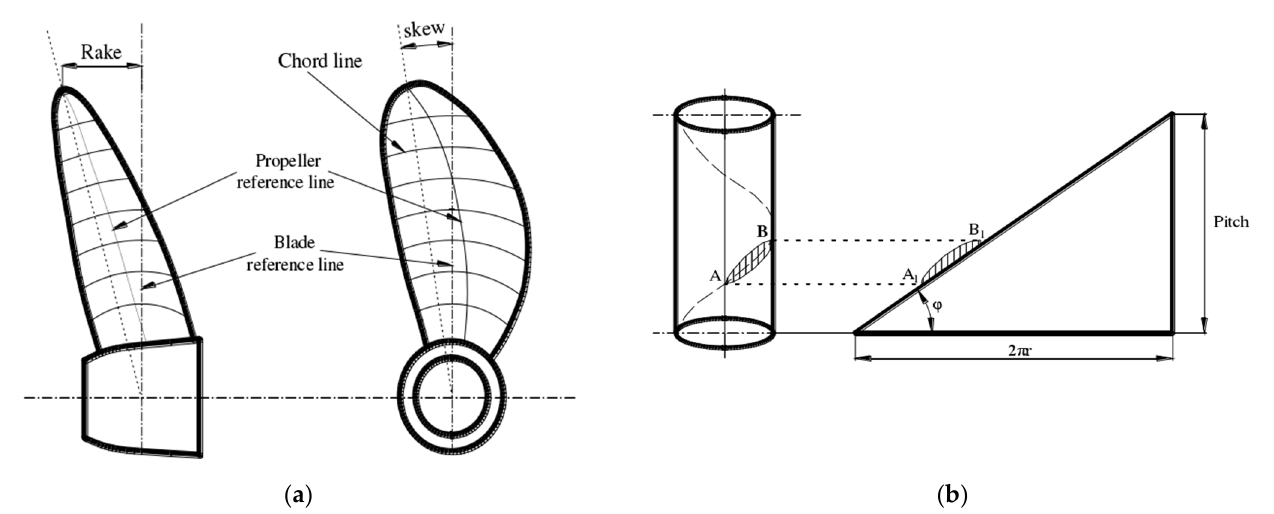
Figure 4. Diagram of pump-jet rotor blade: ( a ) rake and skew; ( b ) pitch. Table 1. Main parameters of pump-jet.